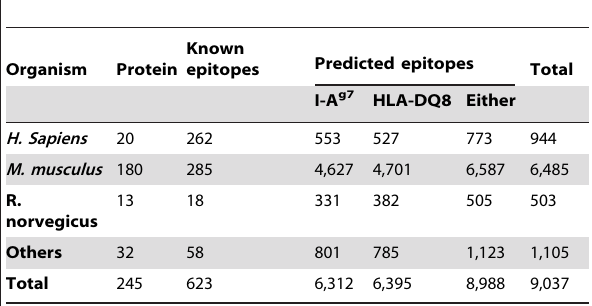
Table 4. The statistical results of the TEDB 1.0 database.